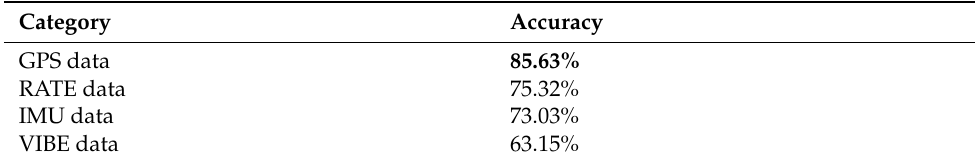
Table 14. Test results from CNN.